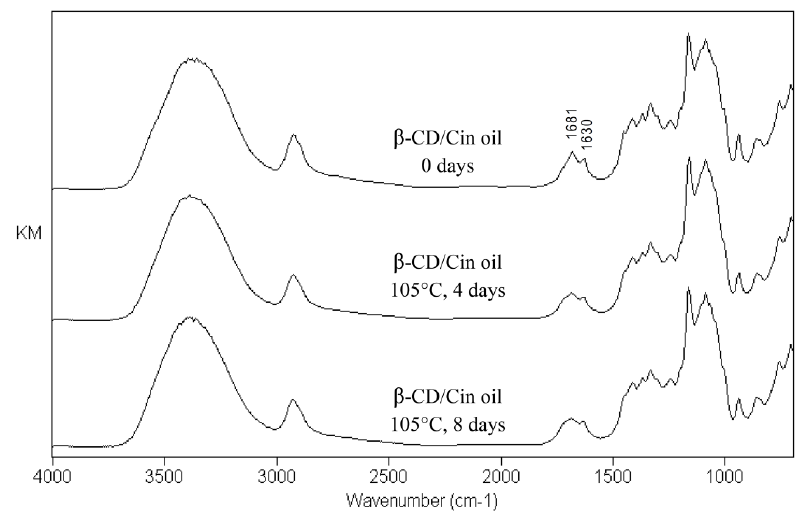
Figure 4. FTIR spectra of Cinnamomum osmophloeum leaf oil microcapsules after the dry-heat aging treatment.